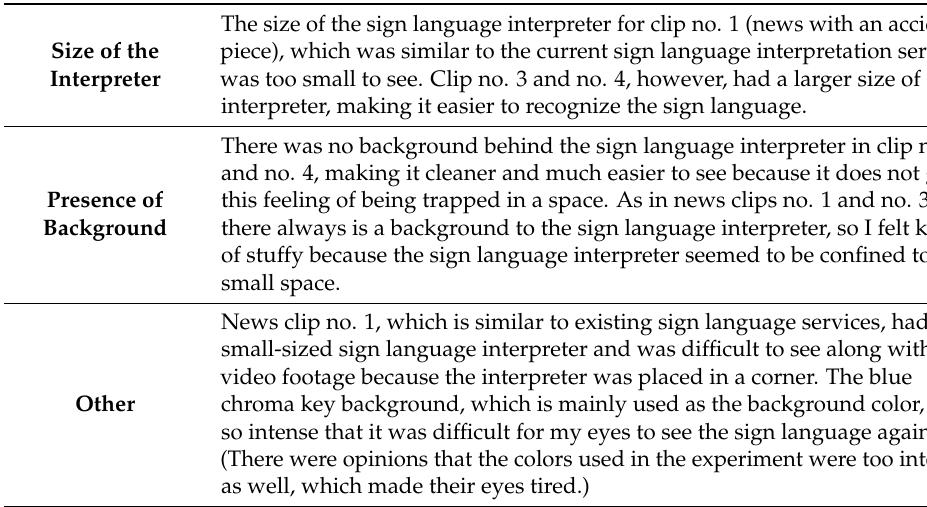
Table 6. Subjects’ opinions on the news Table 6. Subjects ’ opinions on the news clips.